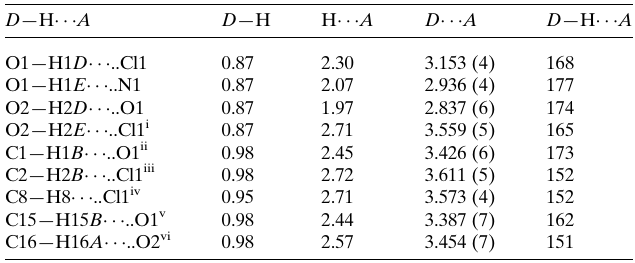
Table 2 Hydrogen-bond geometry (A˚ , (cid:5) ) for ( II